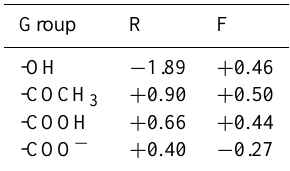
Table 6. Resonance (R) and field (F) values as defined by Swain and Lupton (1968) for the chemical groups involved in the present SAR (taken from Swain et al.,